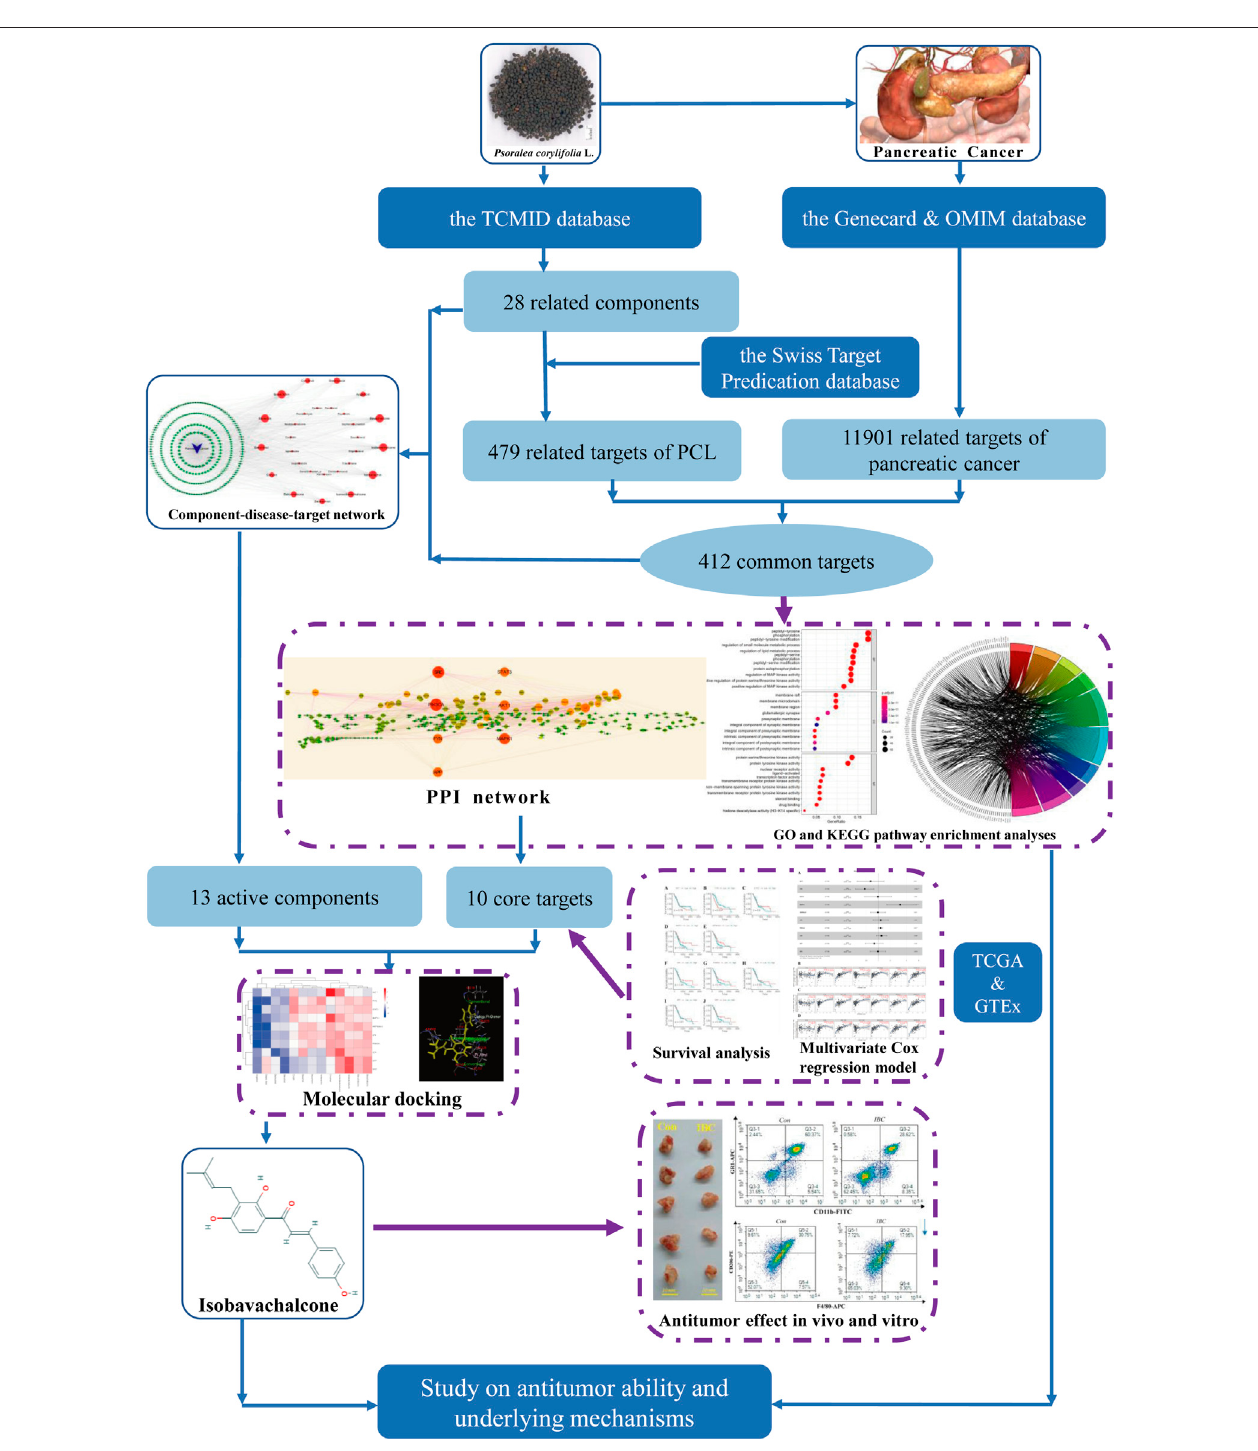
FIGURE 1 | Research procedures applied in the study searching for an antitumor agent and their potential mechanisms.